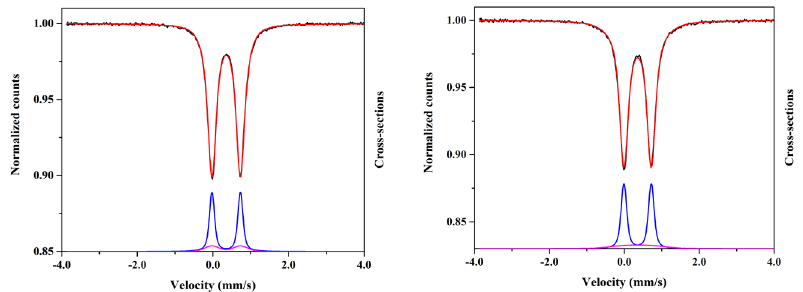
Figure 3. Mössbauer spectra of the Fe02 ( right ) and Fe02-Q ( left ) samples acquired at 293 K (black line) and the corresponding fit (red line). The absorption cross-section of each contribution is also shown.